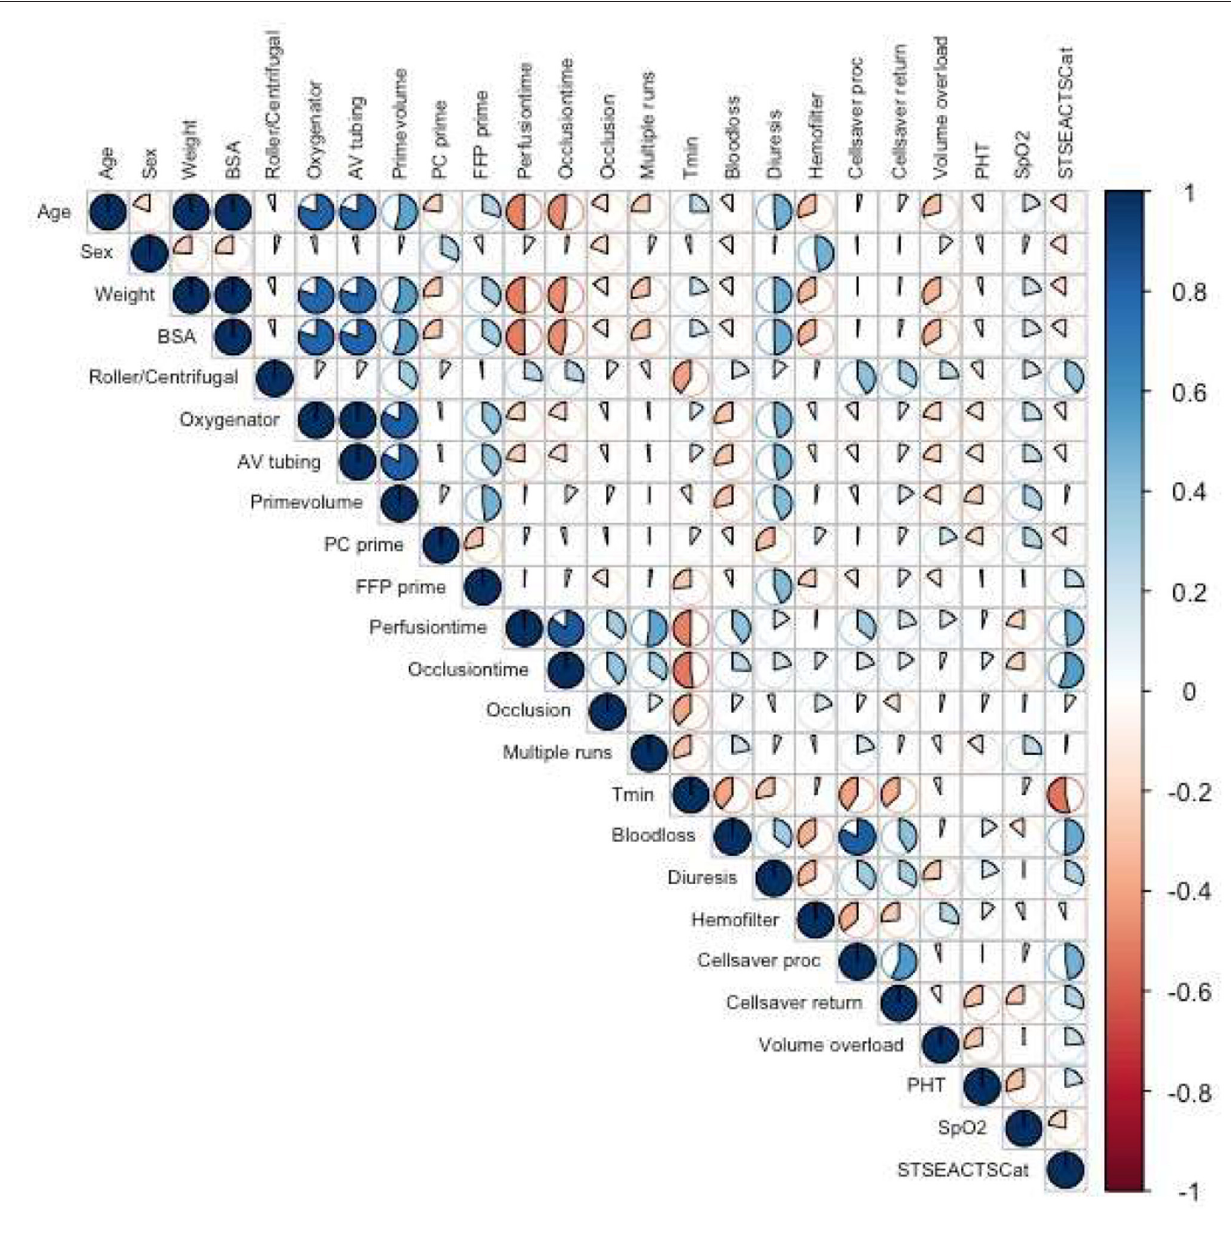
FIGURE 2 | Correlation plot of correlations between covariates calculated with Spearman correlations. AV, arteriovenous; BSA, body surface area; FFP, fresh frozen plasma; PC, red blood cell concentrate; PHT, pulmonary hypertension; proc, processed; return, returned; SpO2 peripheral oxygen saturation; STSEACTSCat, STSEACTS mortality risk category; Tmin, minimum temperature achieved during